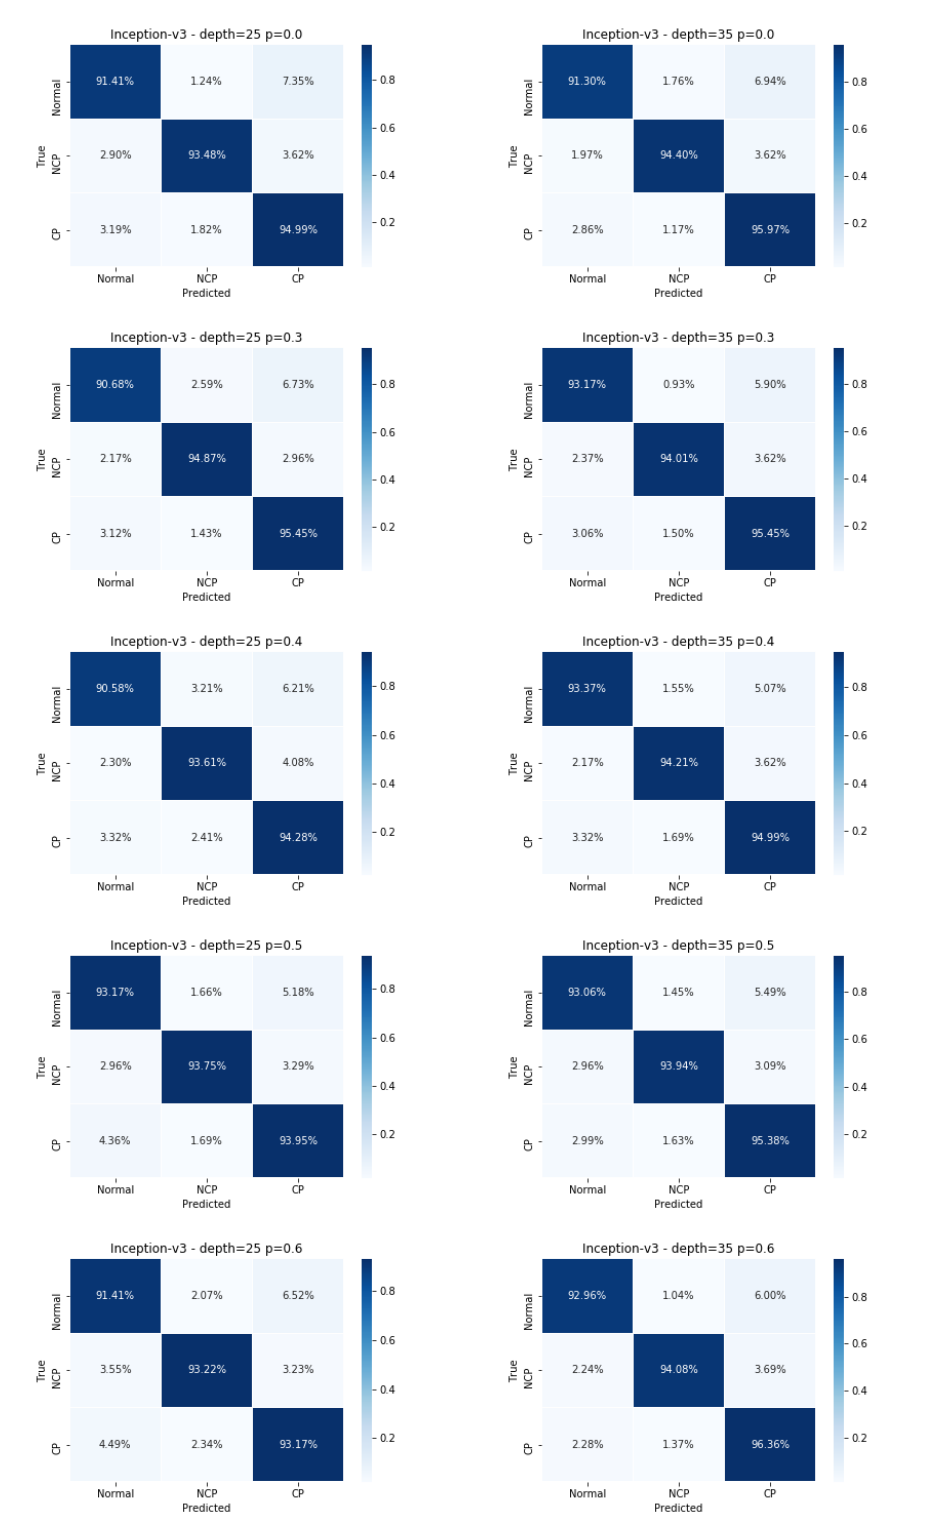
Figure 12. Inception-V3 individual models—The normalized matrices for the individual models built varying the dropout rate p using a CT scan depth of 25 and 35